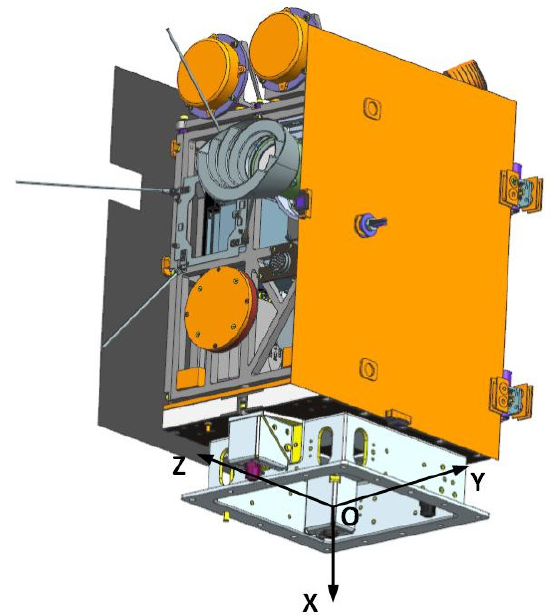
Figure 1. Luojia 1-01 satellite coordinate system.